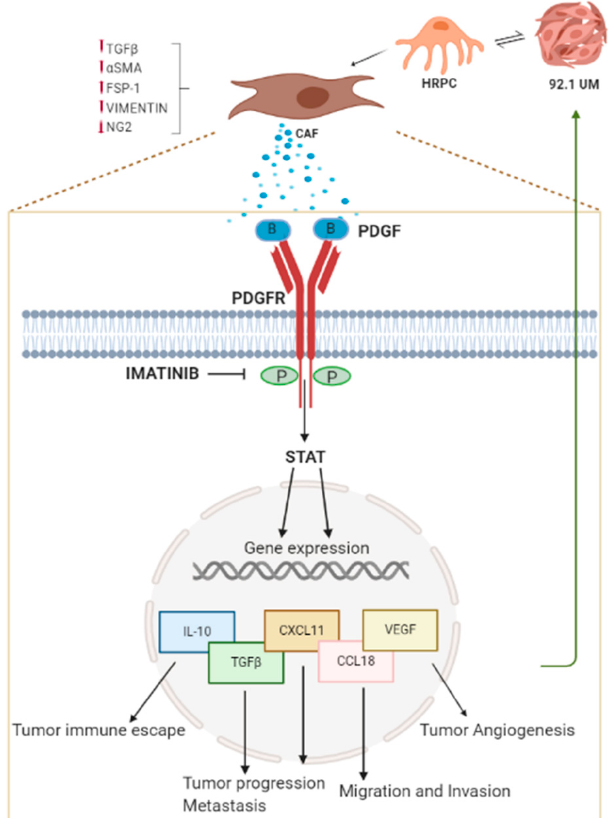
Figure 6. Putative signaling pathway involved in the PDGF-BB-mediated increase in HRPC–CAF transition. In the proposed model, PDGF-BB is involved in HPRC-CAF transition induced by